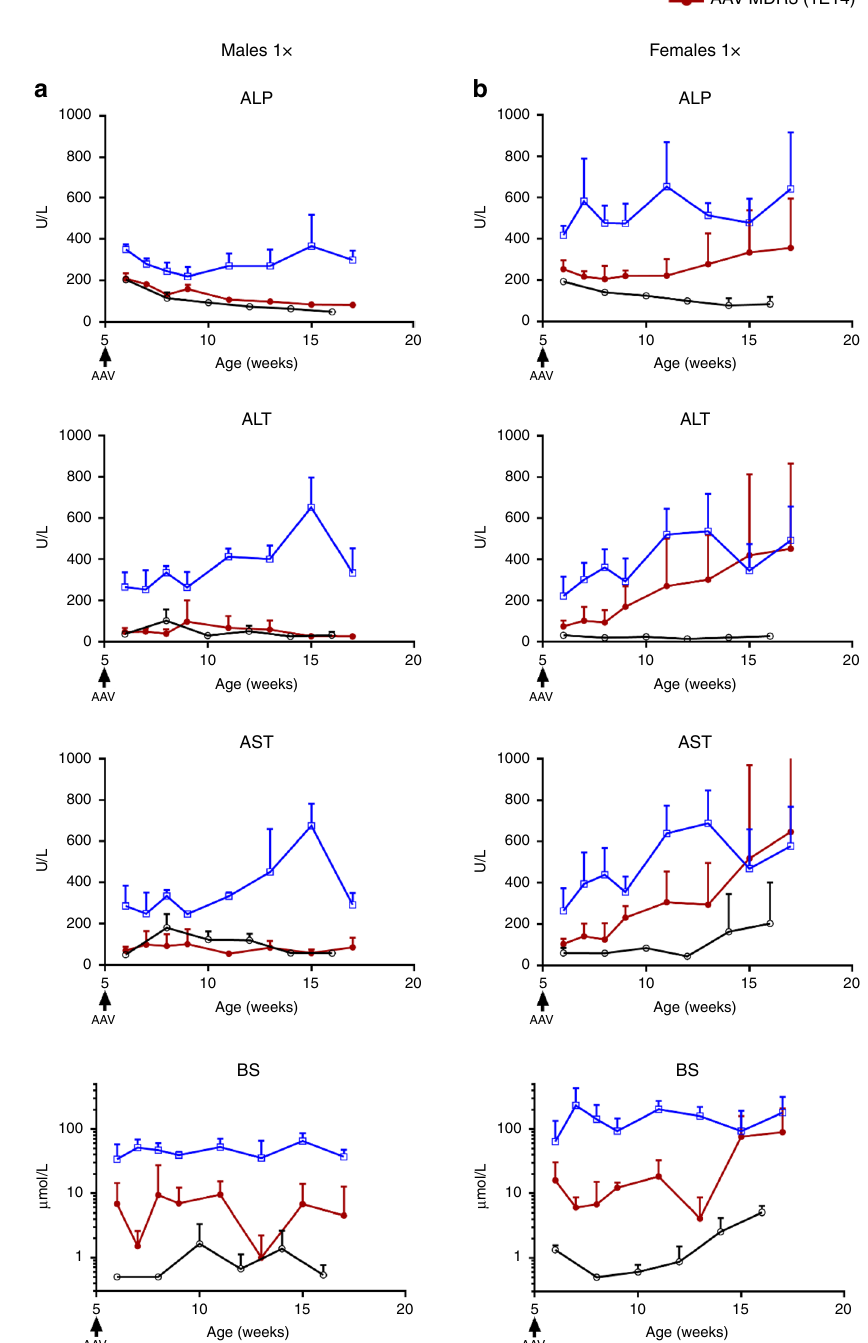
Fig. 6 Serum biomarker levels for Abcb4 − / − mice treated at 5 weeks of age with AAV-MDR3-Aco. The therapeutic effect of AAV treatment is shown in males ( a ) and females ( b ) that were treated with AAV-MDR3-Aco at 1 × 10 14 VG/kg one time (1×, red, fi lled circles; n = 4 M/4 F), using as controls saline- treated (blue, open squares; n = 3 M/4 F) and untreated Abcb4 + / + (WT) mice (black, open circles; n = 3 M/3 F). Data are presented as mean + SD. ALP alkaline phosphatase, ALT alanine transaminase, AST aspartate transaminase, BS bile salts. Source data are provided as a Source Data fi